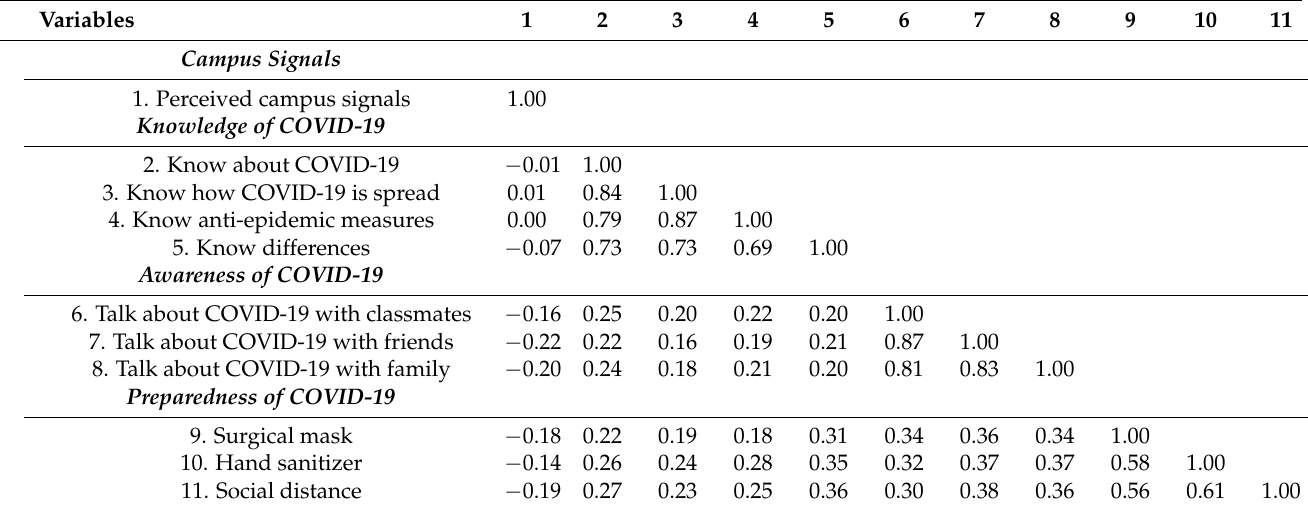
Table 3. Correlations between variables for analysis of a structural regression